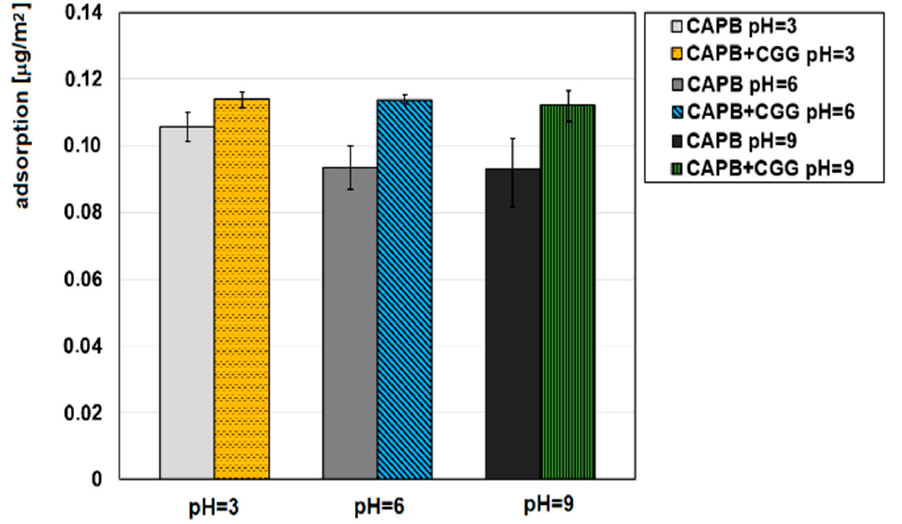
Figure 7. Influence of CGG (200 ppm) on the CAPB adsorption (0.04%) on the glauconite surface at different pH values.